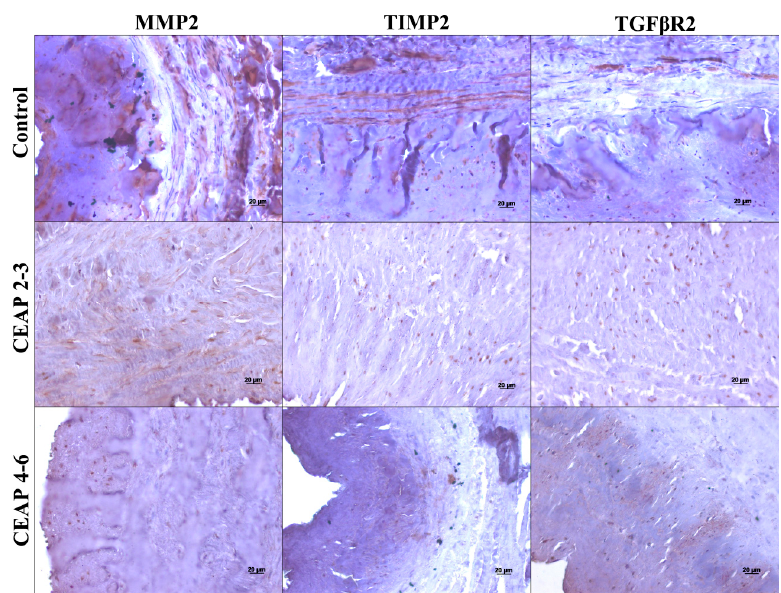
Figure 4. Immunodetection of MMP2, TIMP2, and TGF β R2 in healthy, CEAP2–3, and CEAP4–6 veins. Immunohistochemistry (IHC) was performed and revealed using a peroxidase substrate. Decreased labeling of proteins was observed in chronic venous disease veins. Scale bar represents 20 μ m. Table 2. Immunodetection of MMP2, TIMP2, and TGF β R2 in tissue sections of healthy, CEAP2–3,